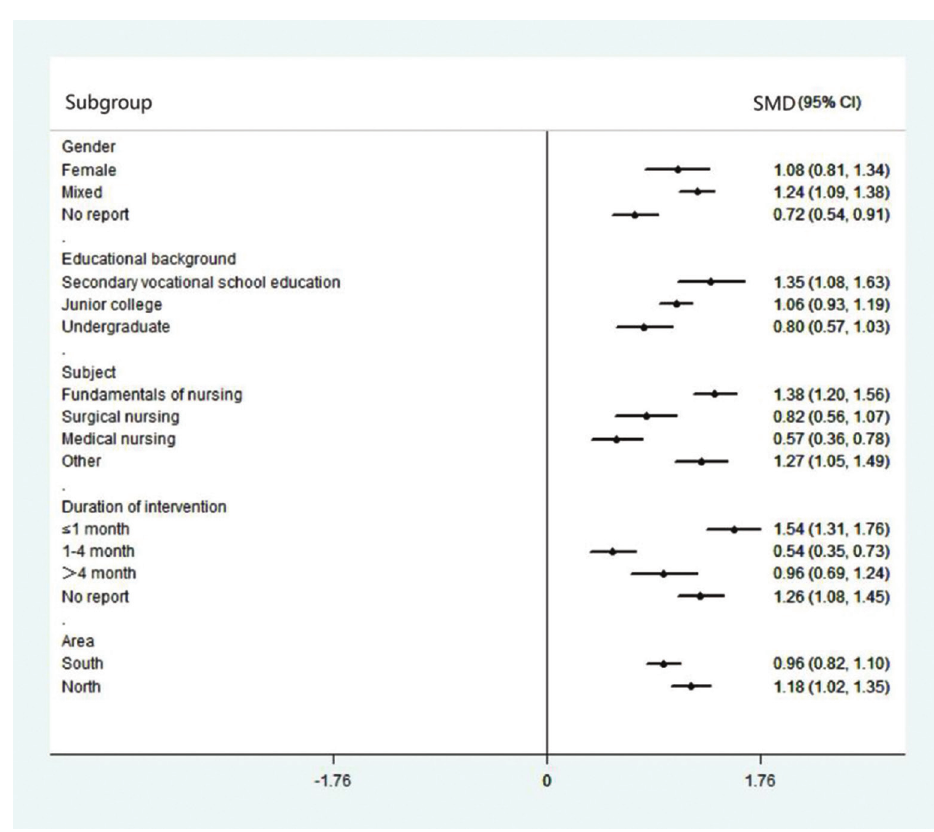
Figure 3. Summary of subgroup analyses for the skills